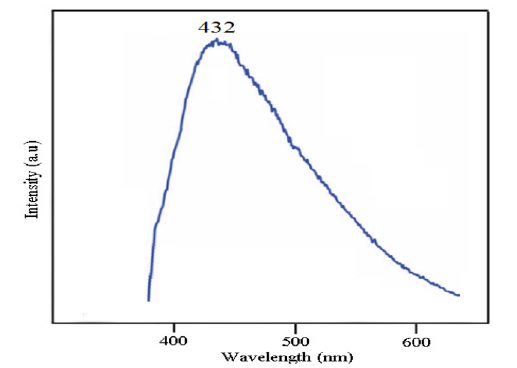
Fig. 5. Pl spectrum of Au nanostructures (sample